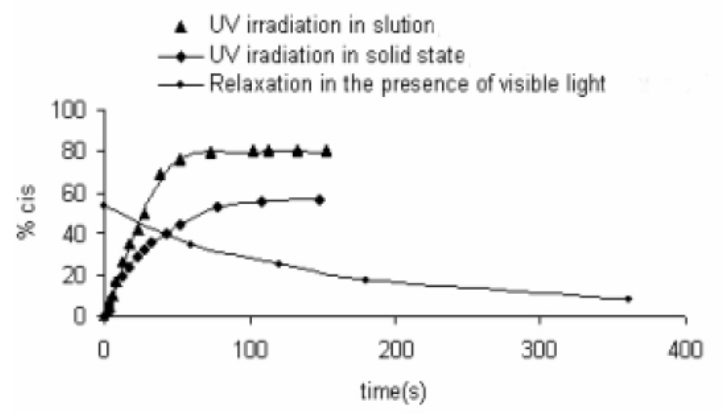
Fig. 13 The kinetic curves corresponding to the trans-cis isomerization process in solution and in solid state and cis-trans relaxation processes in solid state of Sample